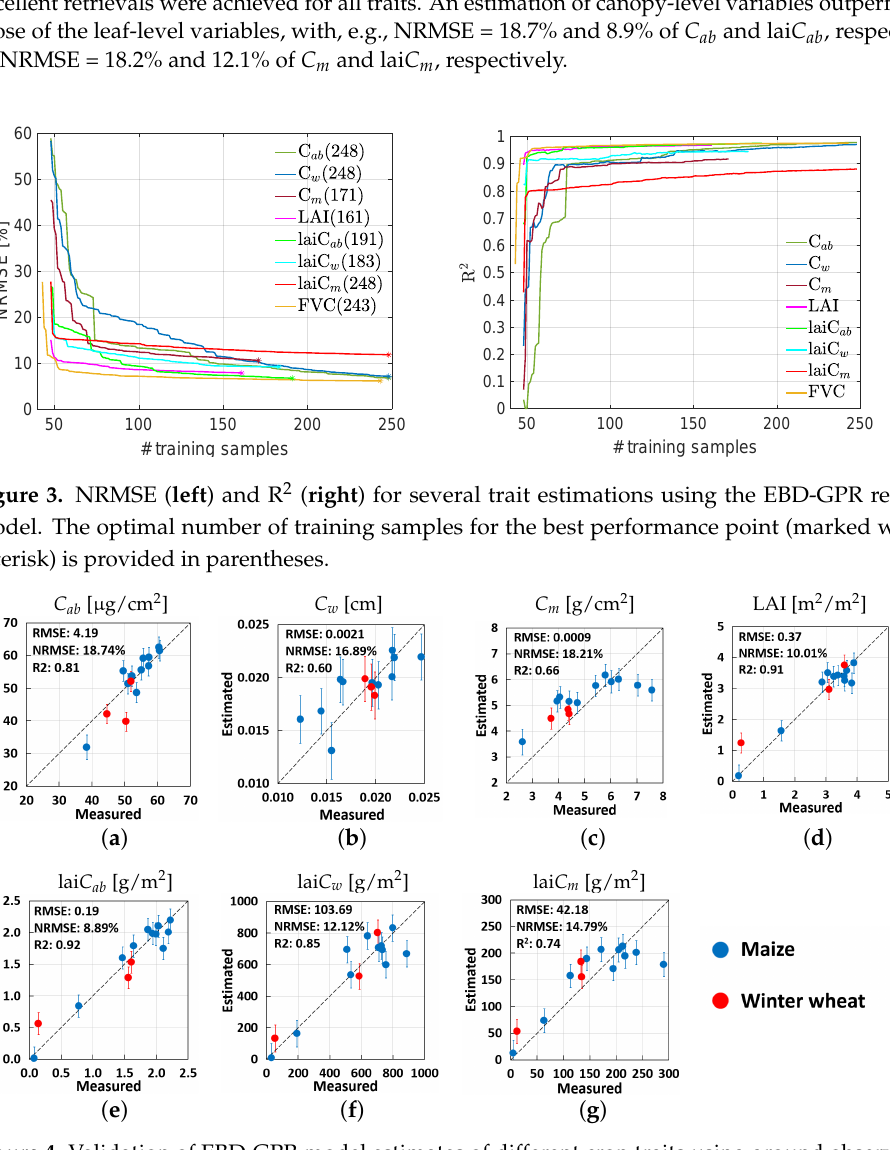
Figure 4. Validation of EBD-GPR model estimates of different crop traits using ground observations from the MNI site (winter wheat and maize) during the 2017 and 2018 growing seasons: C ab ( a ), C w ( b ), C m ( c ), LAI ( d ), lai C ab ( e ), lai C w ( f ) and lai C m ( g ). Measured vs. estimated values are given along the 1:1 line with the associated confidence intervals (1